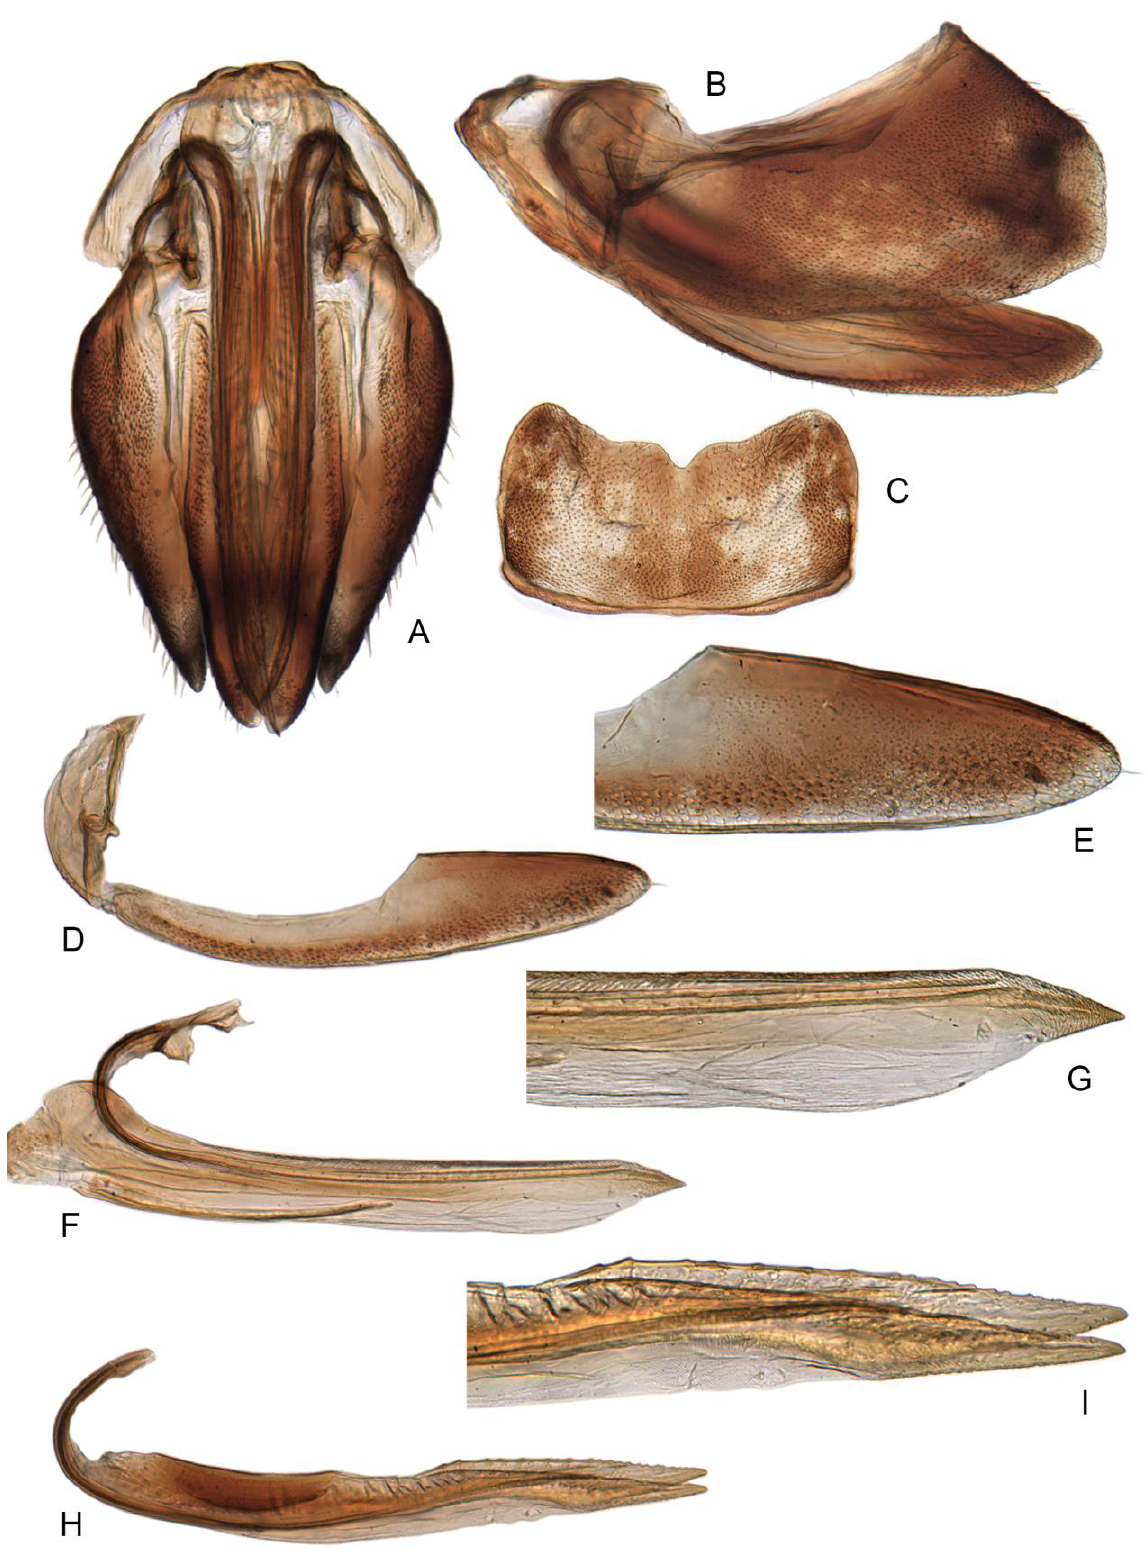
Figure 10. ( A – I ) Female genitalia of Planaphrodes sahlbergii . ( A ) ventral view. ( B ) lateral view. ( C ) abdominal sternum VII, ventral view. ( D ) third valvulae. ( E ) apex of third valvulae. ( F ) first valvulae. ( G ) apex of first valvulae. ( H ) second valvulae. ( I ) apex of second valvulae.